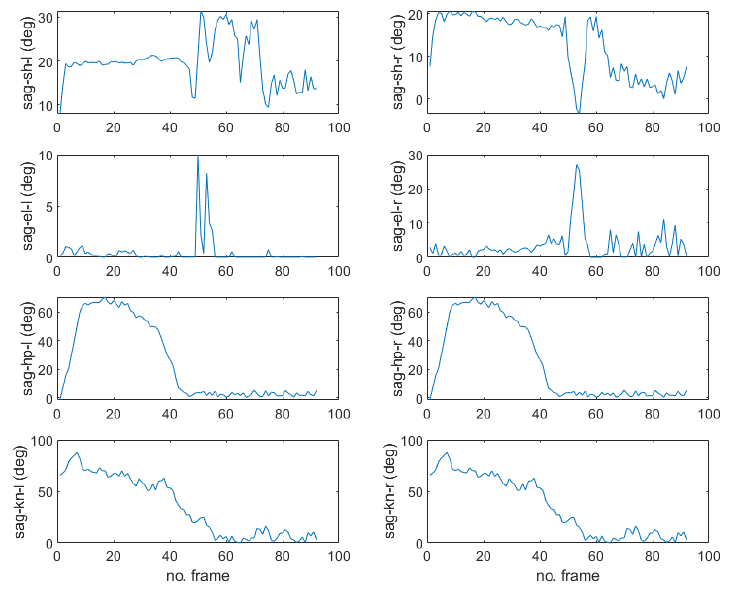
Figure 7. Angular trajectories (in degrees) of the shoulder, elbow, hip, and knee joints in the sagittal plane identified for the sitting and standing motion.